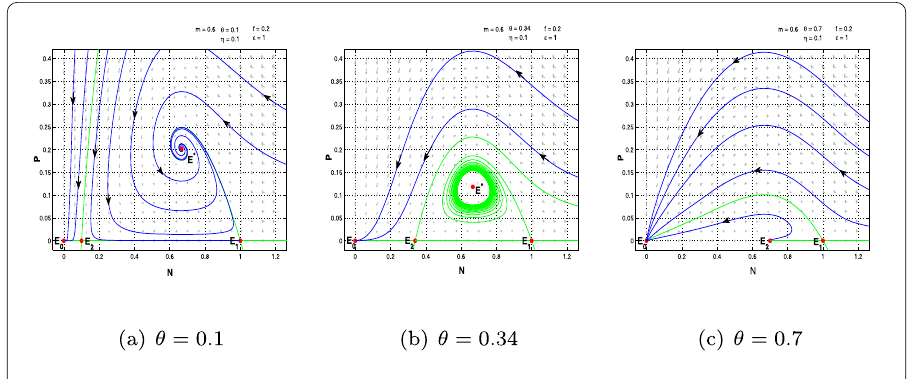
Figure 1 Dynamic behavior of the system (5) with η = 0.1, ε = 1, f = 0.2, m =